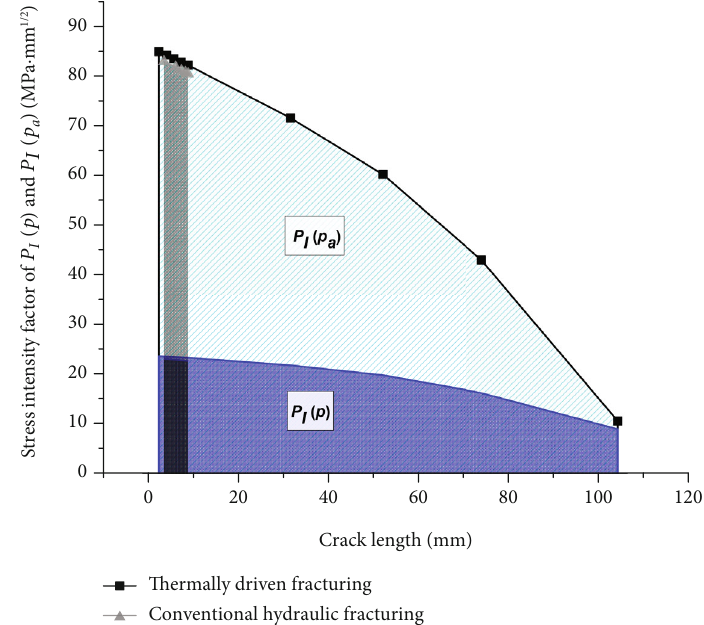
Figure 16: Variation curves of the stress intensity factor due to p and pa at di ff erent crack